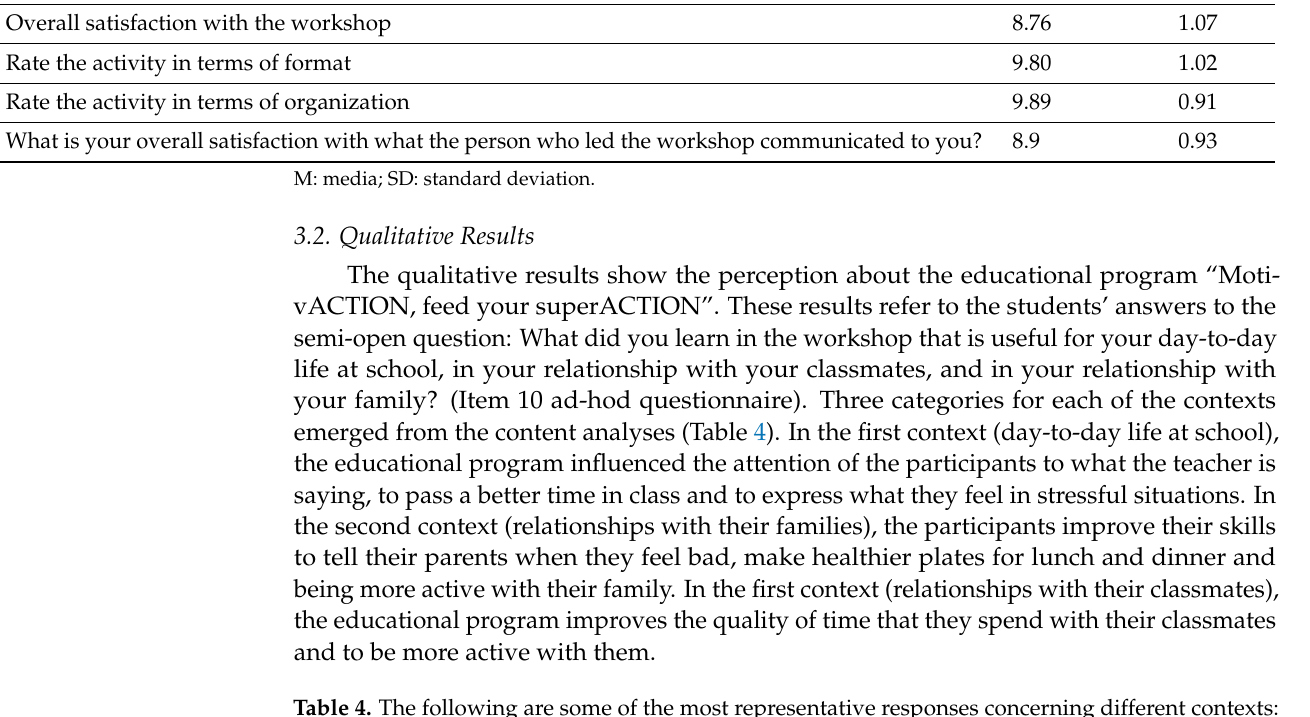
Table 4. The following are some of the most representative responses concerning different contexts: time in school, at home and in a relationship with a